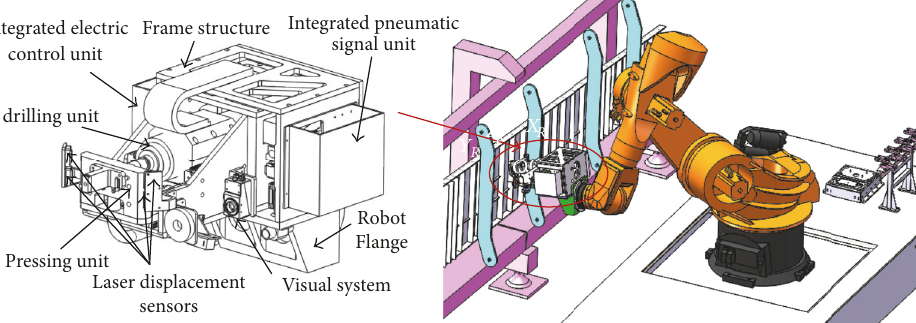
Figure 1: The specific structure of drilling end effector and robot system.